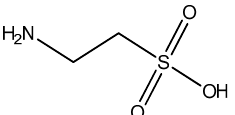
Figure 2. Chemical structure of taurine.